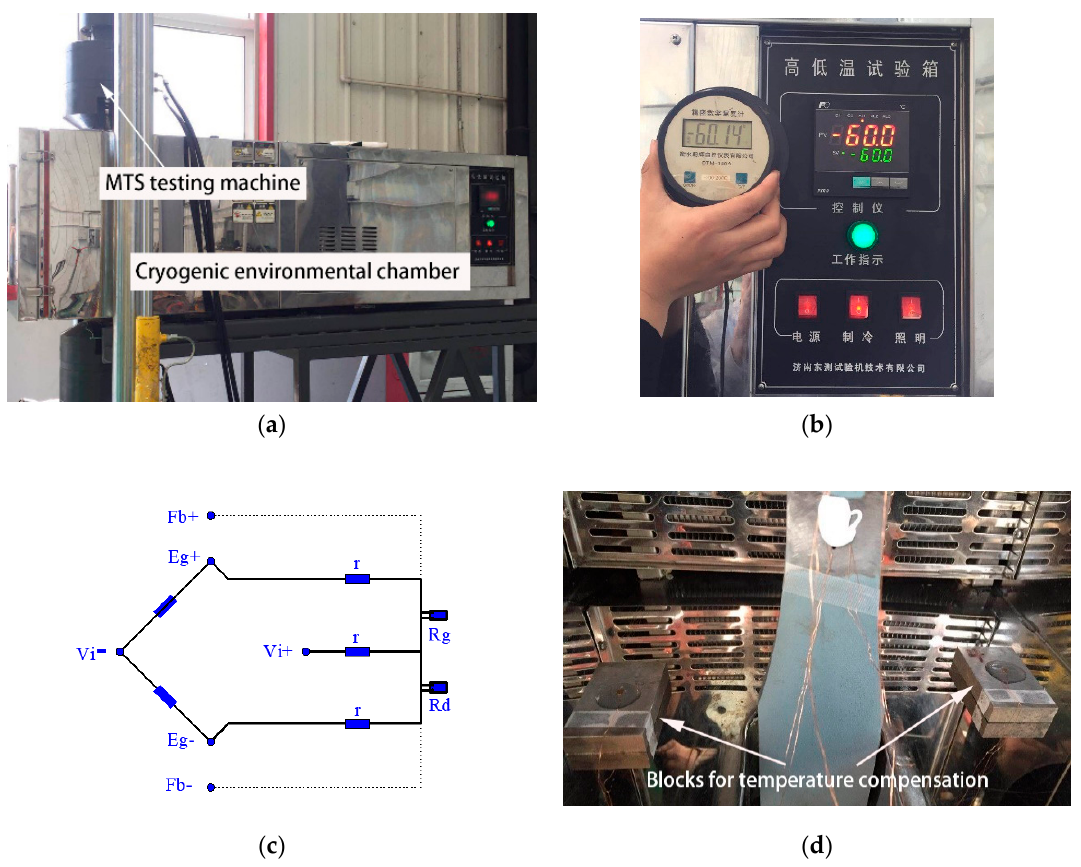
Figure 7. Detail of the test equipment: ( a ) testing set-up, ( b ) calibration of low environmental chamber, ( c ) diagrammatic sketch of half-bridge circuit, and ( d ) physical sketch of half-bridge circuit.